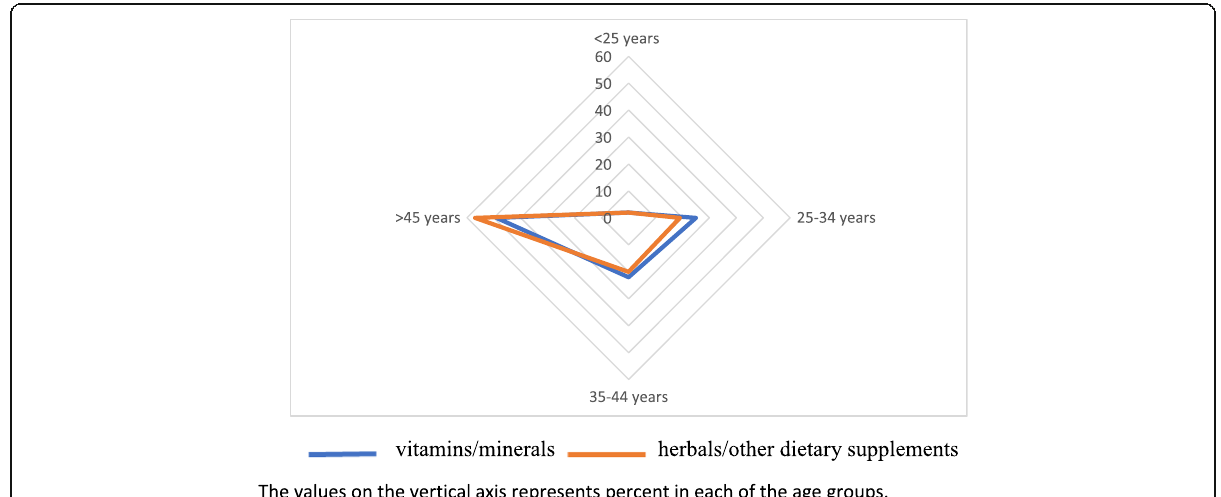
Fig. 1 Radar chart indicating vitamin/mineral and herbals/other dietary supplements use by age groups